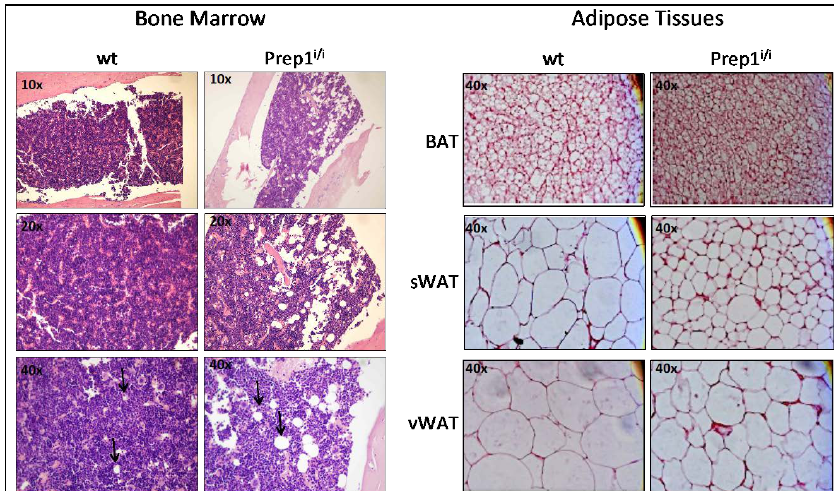
Figure 1. Hematoxylin Eosin staining shows differences in adipose depots between wt and Prep1 i/i mice. HE staining has been performed on ( A ) bone marrow sections of wt (left panel) and Prep1 i/i mice (right panel), 10× (upper panel), 20× (middle panel) and 40× (lower panel) magnifications are shown. Black raws indicate the presence of adipocytes. HE on ( B ) different adipose tissues, i.e. Brown Adipose Tissue (BAT) (upper panel), subcutaneous White Adipose Tissue (sWAT) (middle panel) and visceral White Adipose Tissue (vWAT) (lower panel), 40× magnification is shown. Therefore, we proceeded to compare the entire body-wide distribution of fat depots by in vivo whole-body analysis of wt vs. Prep1 i/i mice, adopting micro-CT imaging techniques. Macroscopic morphological differences are observed between the hypomorphic and wild type groups, as exemplified in Figure 2 and detailed in Table 1. In particular, the weight and total volume of the Prep1 i/i mice are on average 15% ( p = 0.029) and 16% lower ( p = 0.026) than their control littermates, respectively. This is mainly due to the significant difference in total fat volume, which is 39% lower in Prep1 i/i vs. wt ( p = 0.029). No significant differences are instead observed in volume and density of the lean mass component